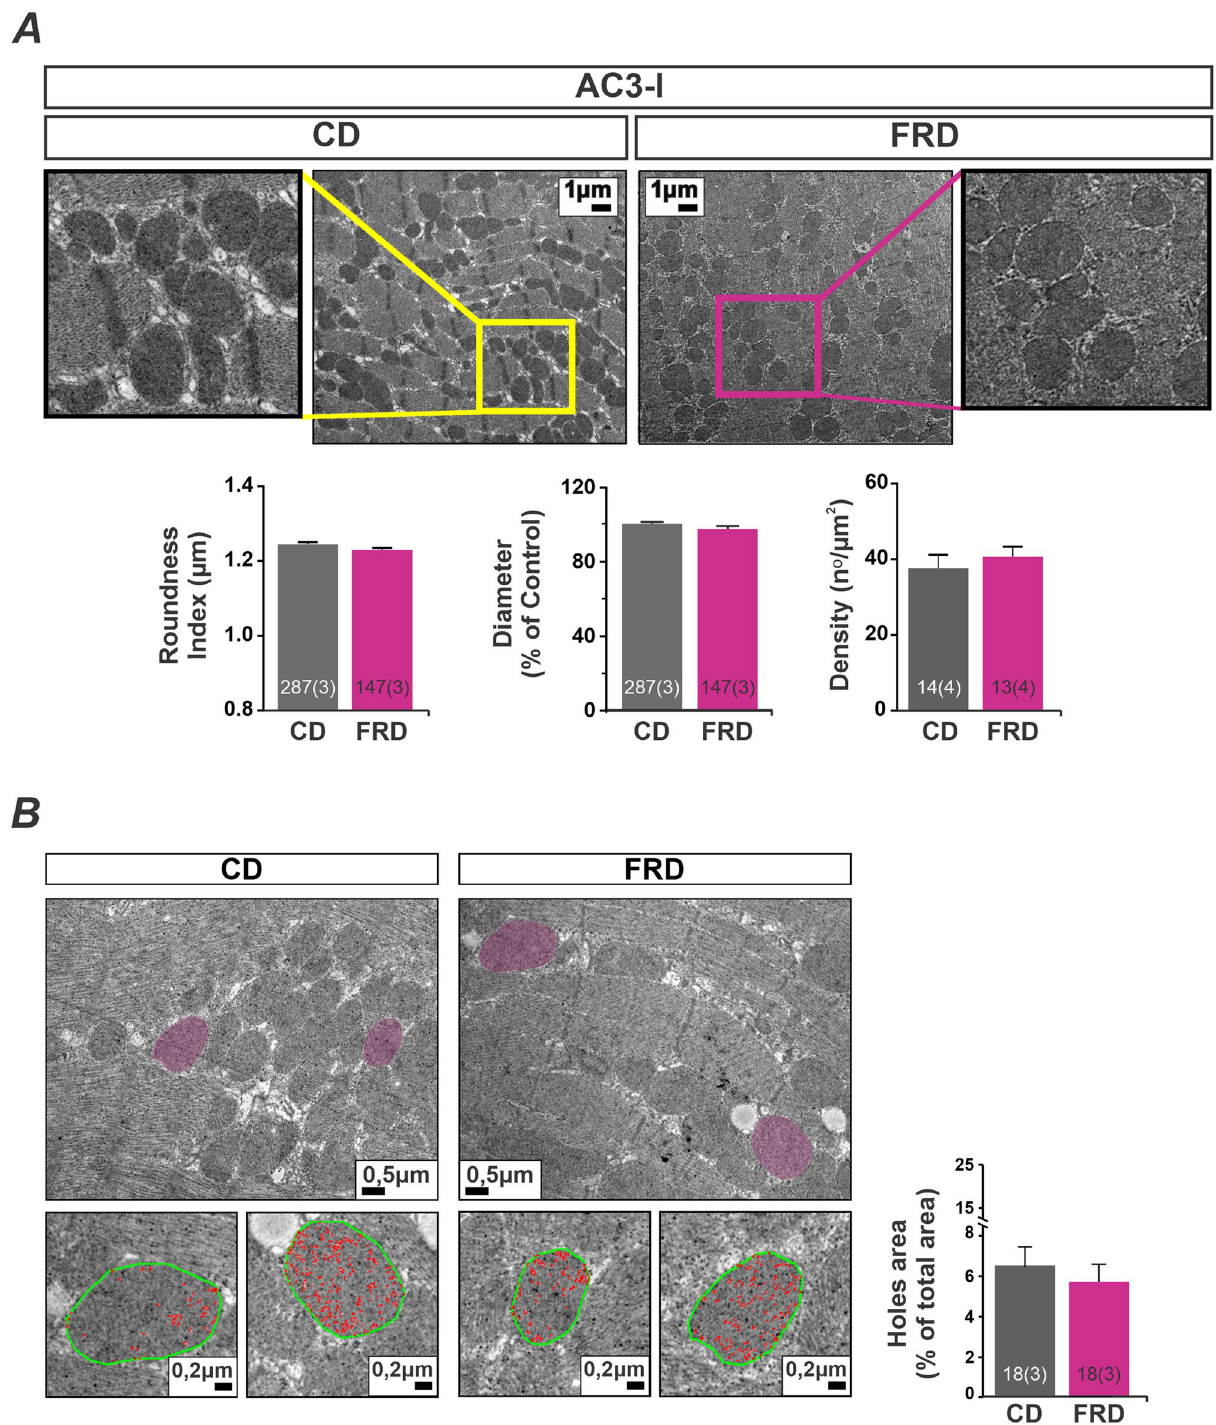
Figure 8. Altered mitochondria morphology and density in prediabetic mouse hearts are prevented with genetic CaMKII inhibition. ( A ) Representative transmission electron microscopy (TEM) photographs from cardiac tissue, and average bar graphs of mitochondria morphology parameters (Roundness and Diameter) and mitochondria density. FRD did not modify the mitochondria morphology in AC3-I mice samples. ( B ) Representative TEM photographs of hearts from CD and FRD treated AC3-I mice, showing the analysis developed to measure the area of holes in the mitochondria selected (pink area). The magnified photographs below show the skeletonized mitochondria (green line) and the holes area (red line). The bar graph shows the average data indicating that mitochondria structure from AC3-I mice heart is similar in CD and